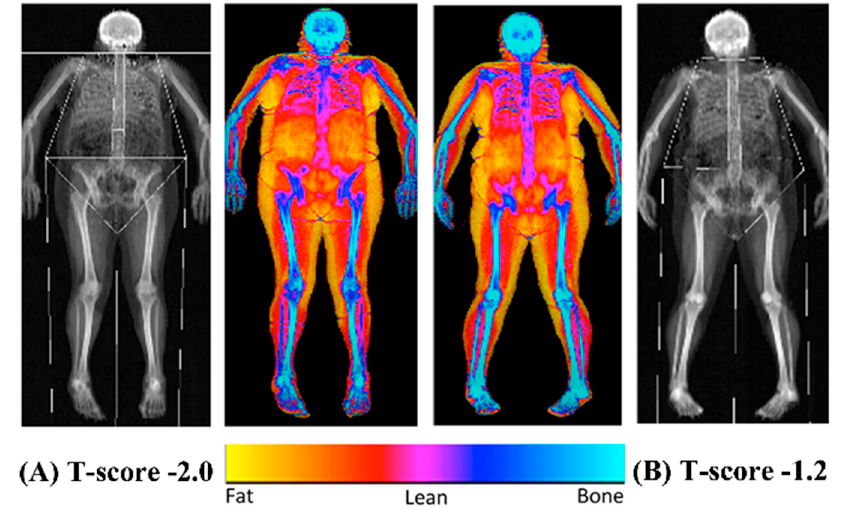
Figure 1. Representative dual energy x-ray absorptiometry scans of a female ( A ; T-score: − 2.0) and male ( B ; T-score: − 1.2) with osteopenia.